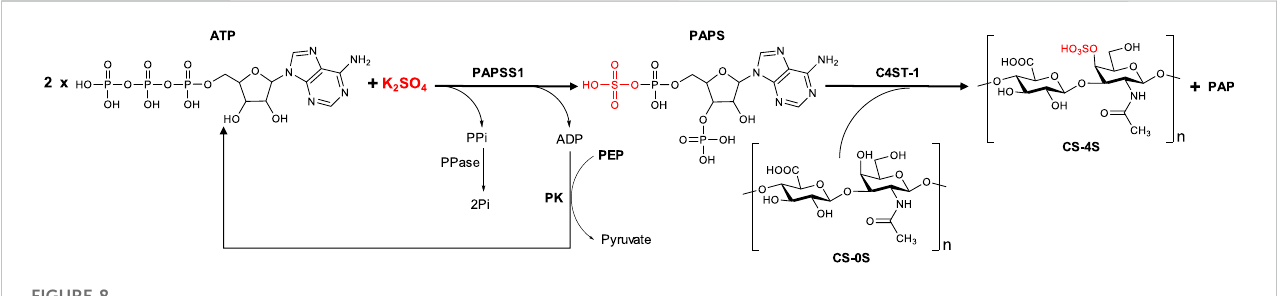
FIGURE 8 Schematic representation of the biocatalytic cascade developed for the sulfation of unsulfated chondroitin. The cascade involves the regeneration of one of the two ATP molecules used for the in situ synthesis of PAPS.